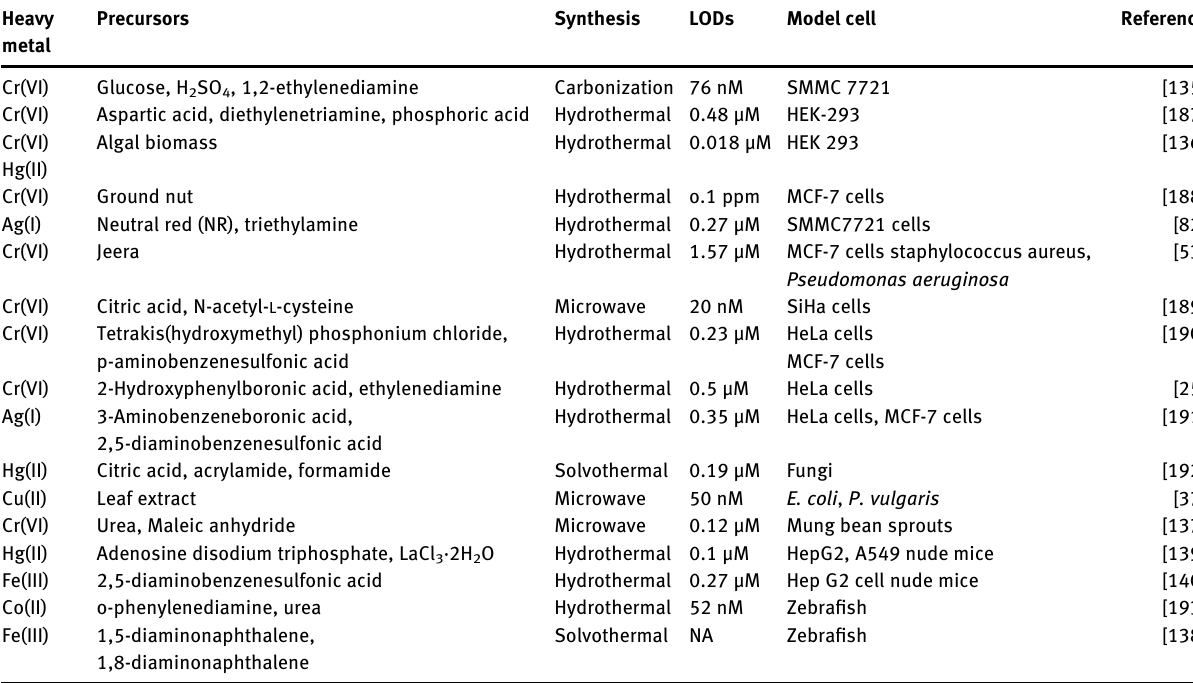
Figure 10: Schematic illustration of carbon dots (CDs) used as a bioimaging reagent. Reprinted from Zhou et al. ’ s work with the kind permission of Elsevier [139]. Copyright (2019) Elsevier.